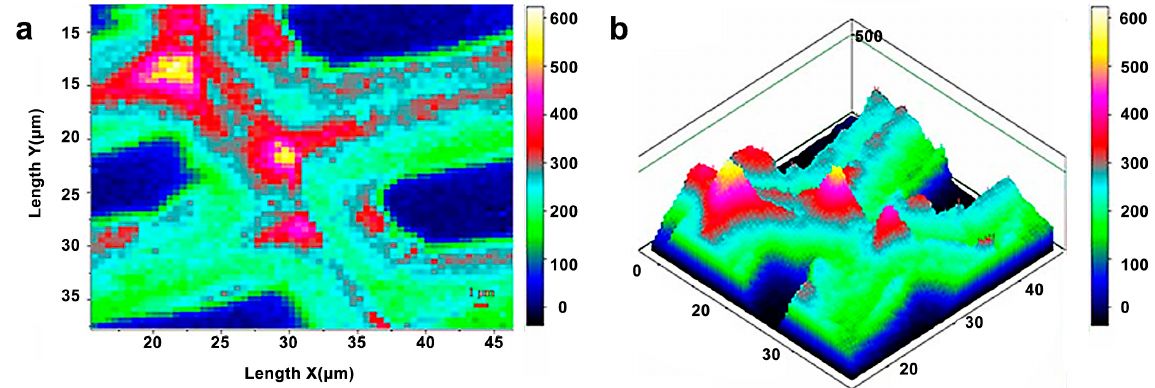
Figure 11. Raman images of lignin spatial distribution in cell wall: two-dimensional ( a ) and three- dimensional ( b ) representations. Bright white/yellow locations indicate high lignin concentration; dark blue/black regions indicate very low concentration, e.g., lumen area.